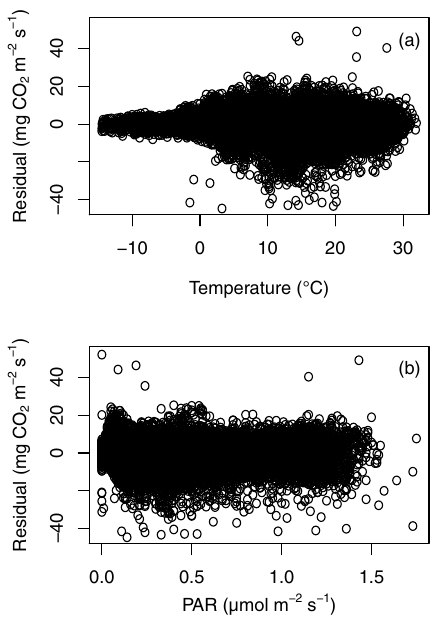
Figure 5. The residuals as a function of temperature and PAR in the year 2013 in Finnish Lapland, 68 ◦